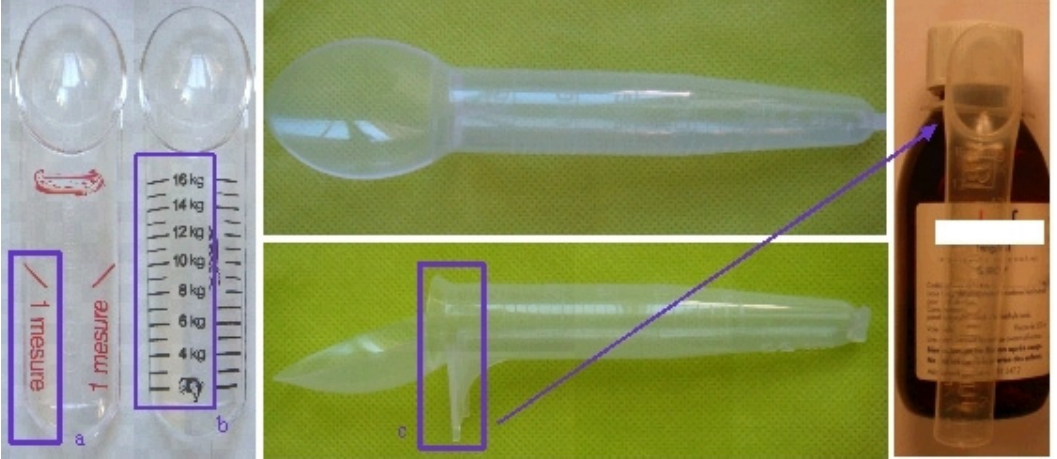
Figure 5. Examples of different M-T-spoons ® (a: dose by spoon; b: dose by kg; c: spoon attached to the